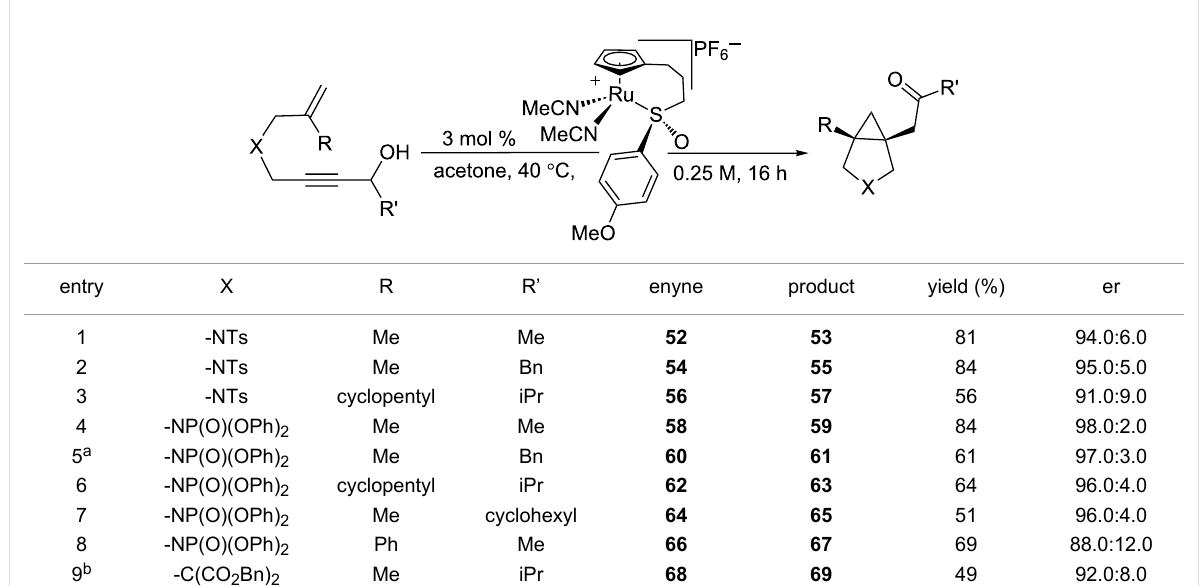
Table 7: Other substrate tethers for redox